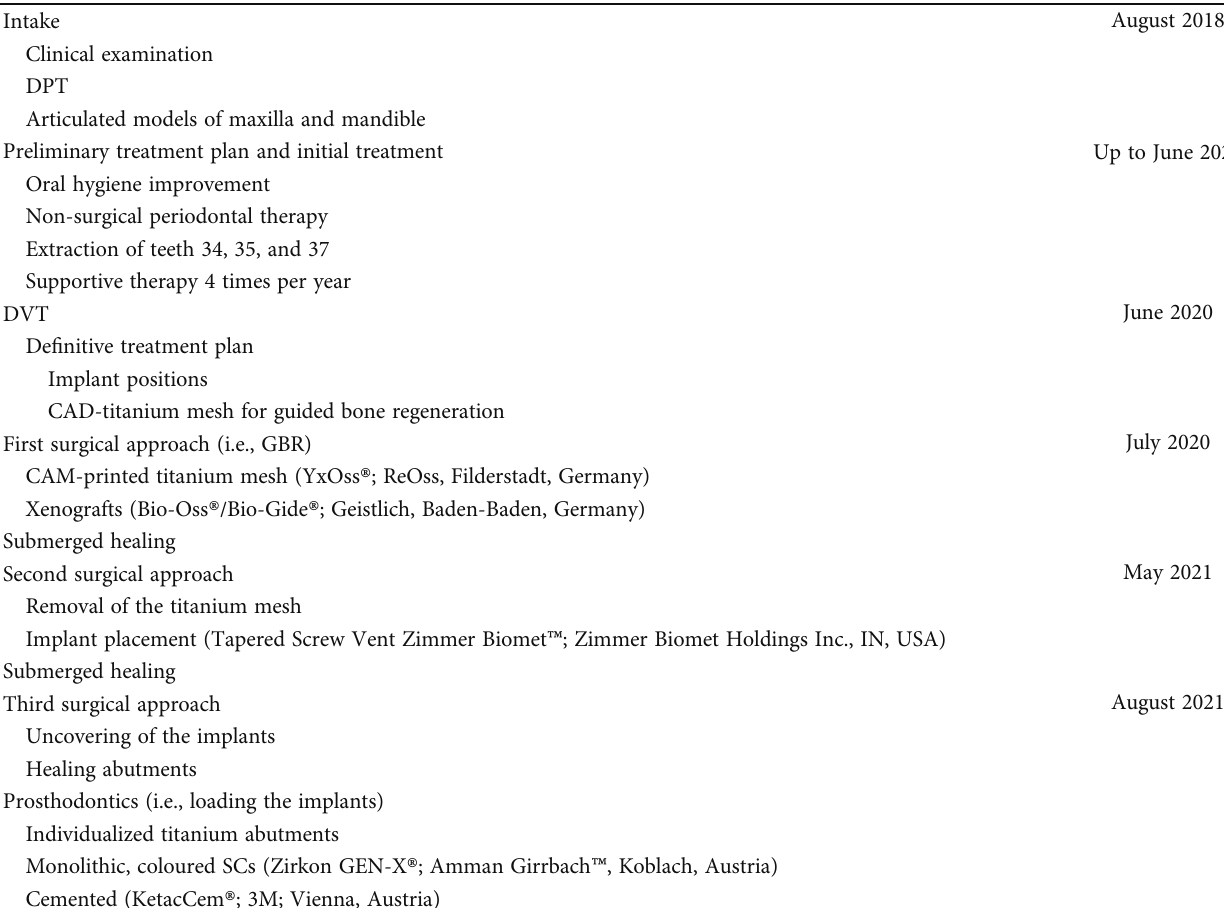
Table 2: Chronological order of the treatment.